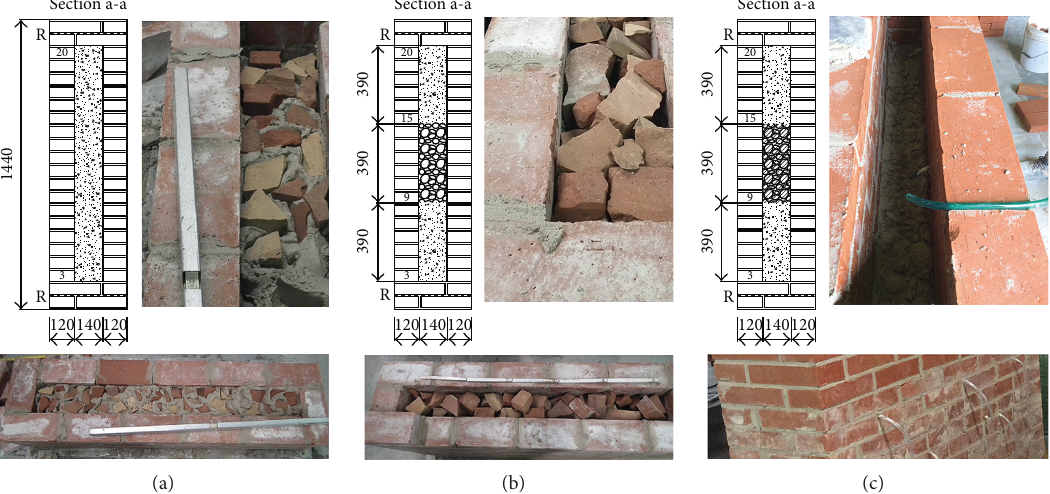
Figure 3: Different typologies of masonry specimens: (a) B1-full infill; (b) B2-damaged infill; (c) B3-consolidated infill (dimension in